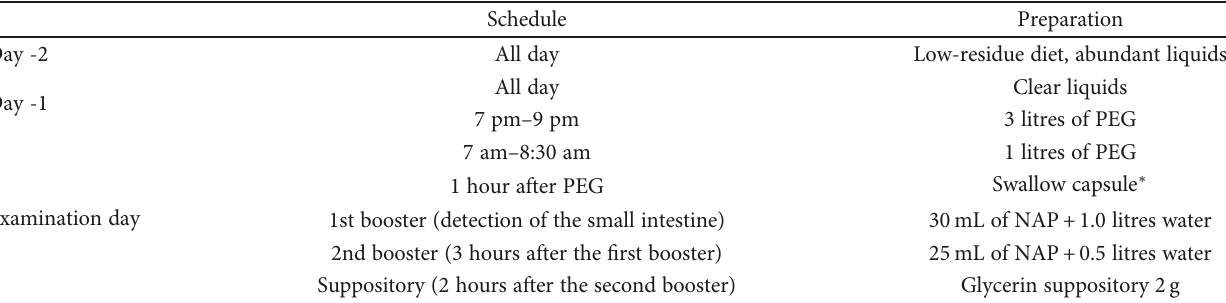
Table 1: Bowel preparation